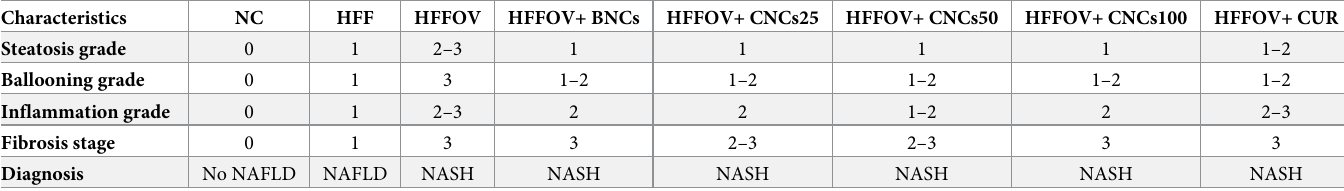
Table 4. Comparisons of liver pathology grades (ranging from 0 to 3 in each case) among the experimental groups.